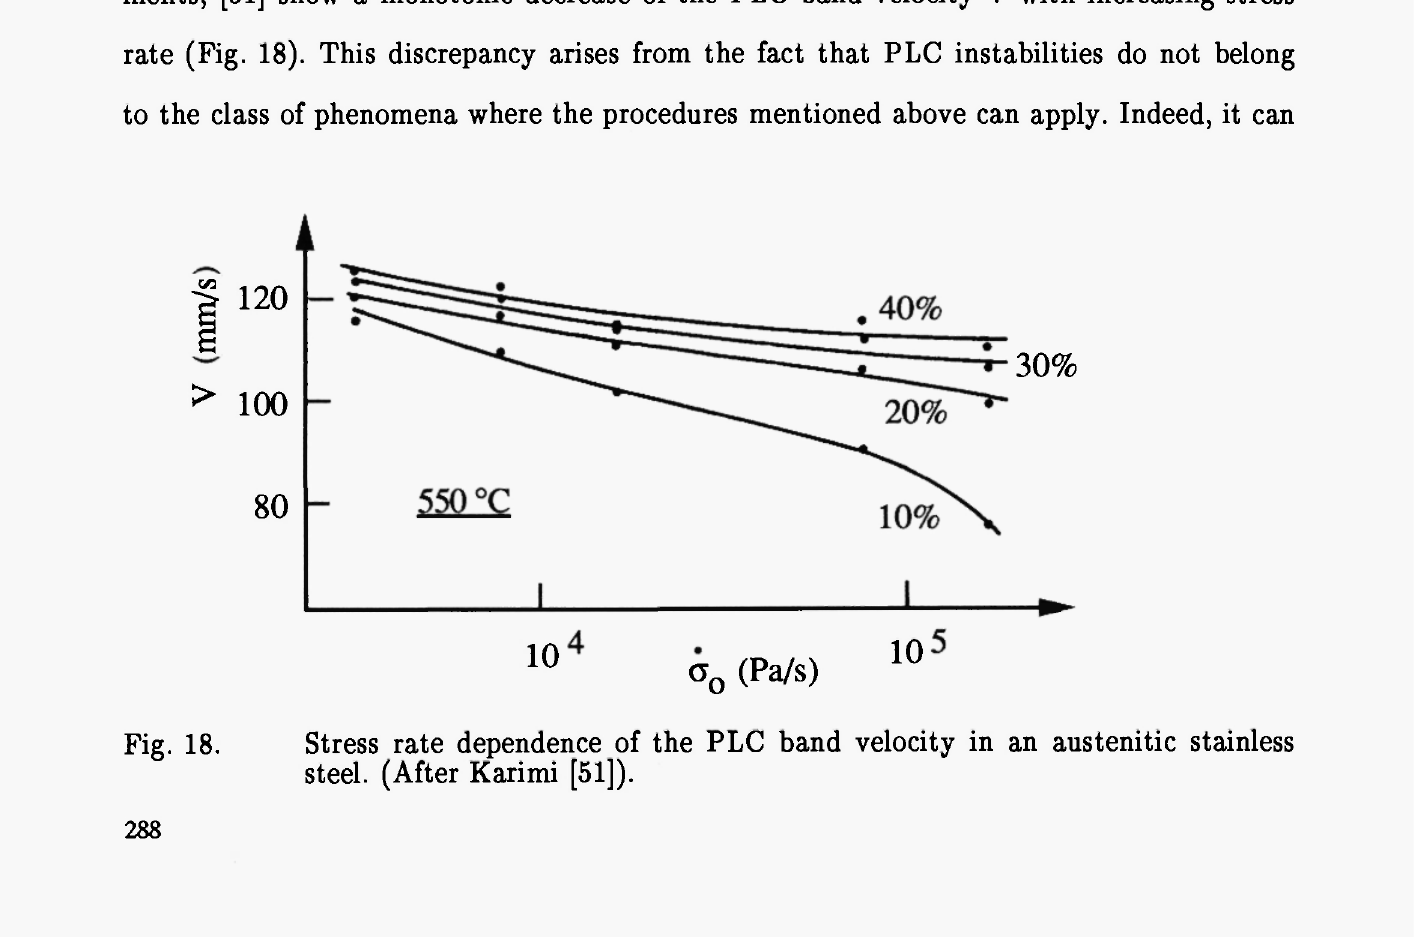
Fig. 18. Stress rate dependence of the PLC band velocity in an austenitic stainless steel. (After Karimi